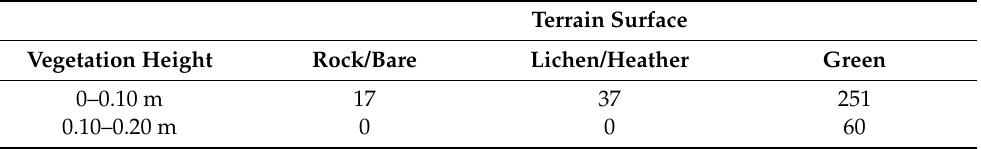
Table 2. Frequency distribution of 365 ground reference points recorded in